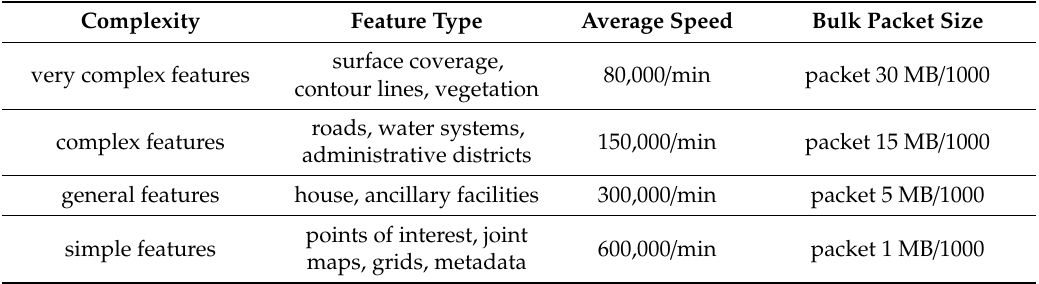
Table 7. Import speed